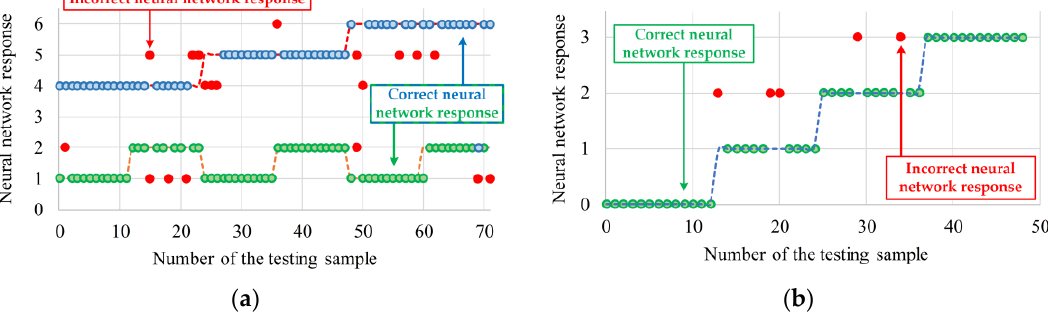
Figure 10. SOM–MLP network response: ( a ) mixed faults (blue dots—stator winding fault; green dots—rotor bar fault); ( b ) rotor broken bars, T L ≈0 ( s ≈0).